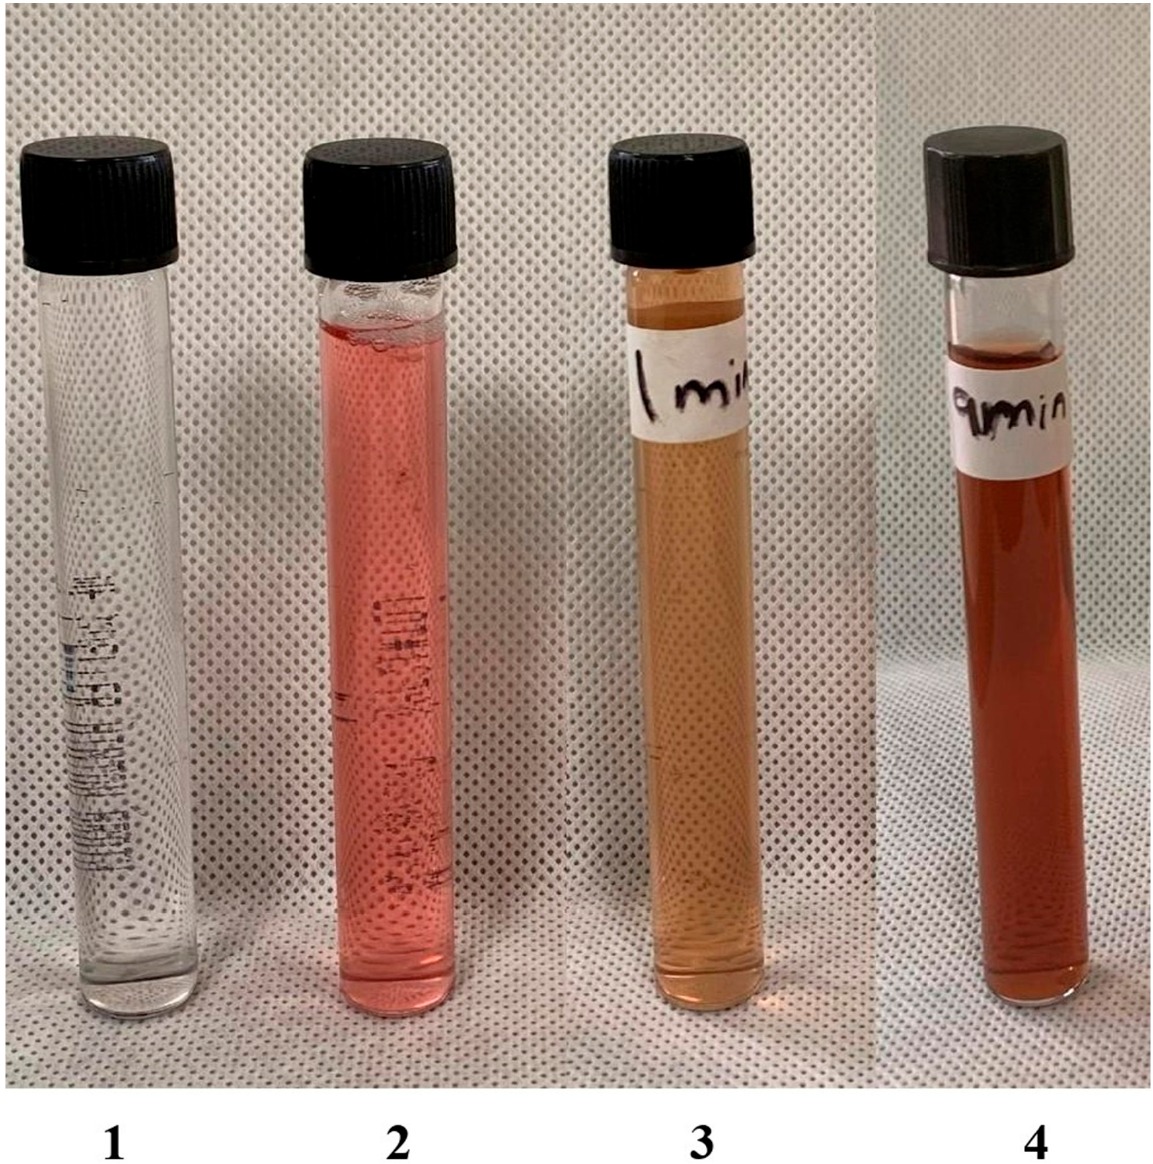
Figure 1. The formation of AgNPs using aqueous extracts of red currants (berries): 1 —silver nitrate solution (AgNO 3 ); 2 —red currant aqueous extract; 3 —reaction mixture after 1 min of exposure to sunlight; 4 —formation red currant nanoparticles (Rc-AgNPs) after 9 min.